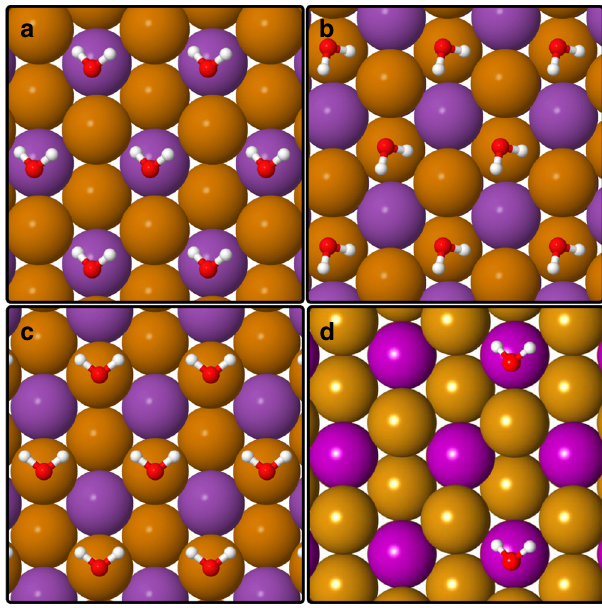
Fig. 3 Van der Waals corrected DFT calculations of the adsorption site for H 2 O on Bi 2 Te 3 (111). The Bi and Te atoms are illustrated as purple and brown spheres, respectively. The energetically most favourable adsorption site is on top of the second layer Bi atom ( a ), followed by adsorption on top of the third layer Te atom ( b ) with a difference of 21 meV. Adsorption on top of the fi rst layer Te atom ( c ) is the least favourable adsorption geometry, being 100 meV higher in energy than the absolute minimum. The optimised con fi guration of the water molecules for a ð 2 ´ 2 Þ supercell in d is essentially the same as for the higher coverage in a .